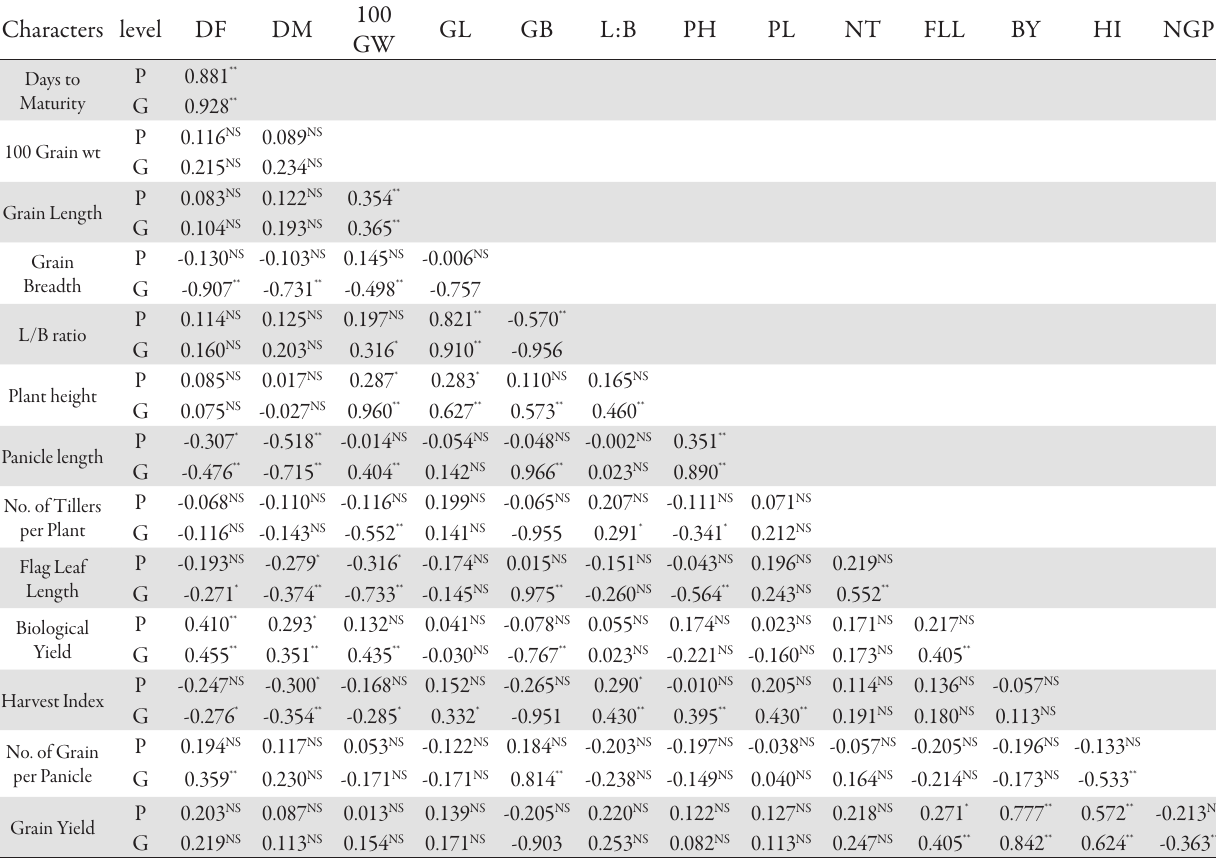
population of hill rice 3